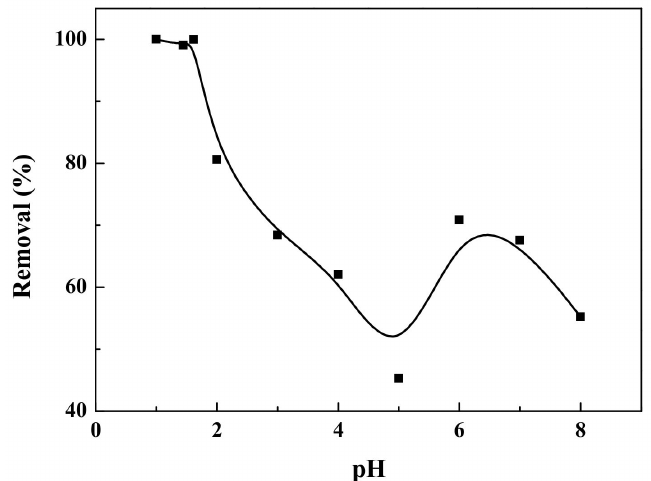
Figure 6. The adsorption effect of carbon-supported metal nickel on reactive brilliant yellow R-4GLN under different pH